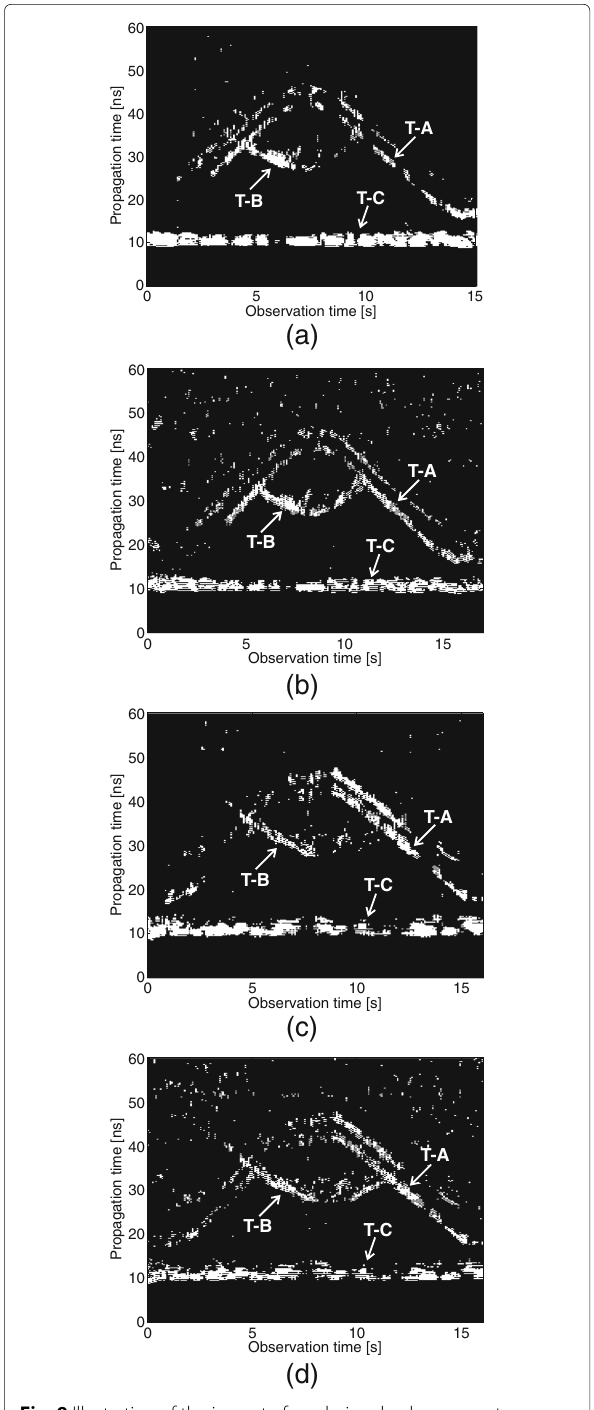
Fig. 9 Illustration of the impact of weak signal enhancement application and radar antenna location on target detection. Scenario 2, sensor S1. The detector outputs for the receiving channel Rx 1,1 : a antenna altitude 1.35 m, no weak signal enhancement has been used; b antenna altitude 1.35 m, advanced normalization has been used; c antenna altitude 1.85 m, no weak signal enhancement has been used; d antenna altitude 1.85 m, advanced normalization has been